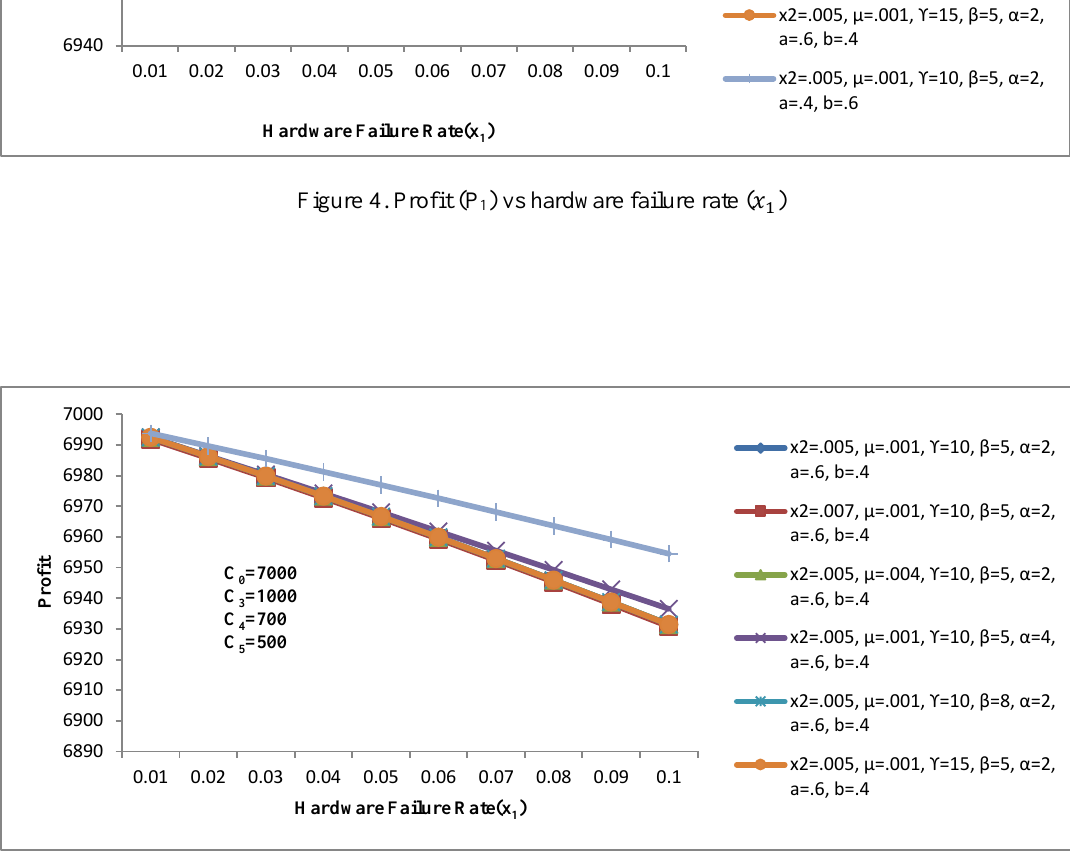
Figure 5. Profit (P 2 ) vs hardware failure rate ( 𝑥